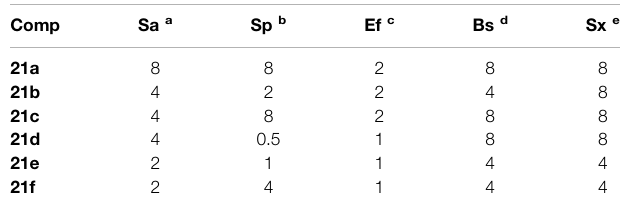
Binding Energy, △ G (kcal/Mol)